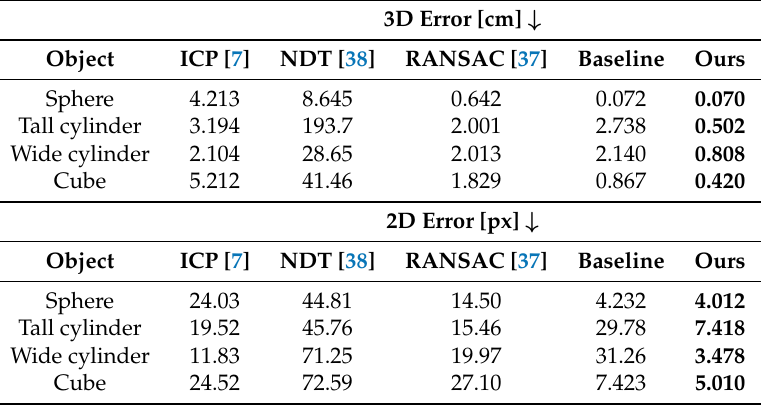
Table 1. Error of primitive shape pose estimation (per object). It is evident that our proposed method outperforms the baseline and the other methods.